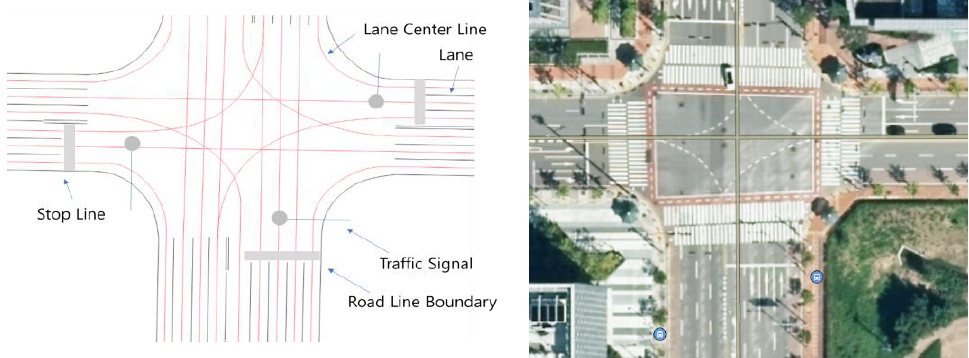
Figure 4. Road line and critical path in the HD map and aerial image.